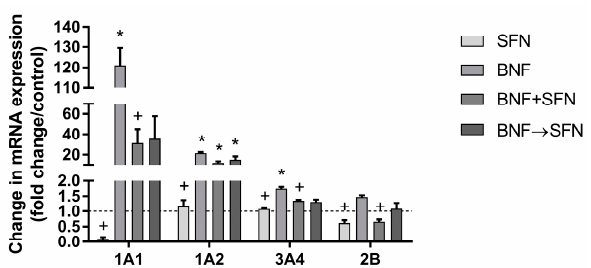
Figure 1. Effect of sulforaphane (10 μ M) on the mRNA expression of individual isoforms of cytochrome P450 in rat hepatocytes treated or non-treated with β -naphthoflavone (10 μ M). Primary rat hepatocytes were incubated at 37 °C for 24 h. The data are expressed as the mean ± SD ( n = 3). The mRNA significantly altered ( p ≤ 0.01) compared to control (*) or β -naphthoflavone (+). BNF β - naphthoflavone; SFN sulforaphane; BNF + SFN co-administration of BNF + SFN; BNF → SFN 6-h BNF pre-treatment followed by SFN addition.